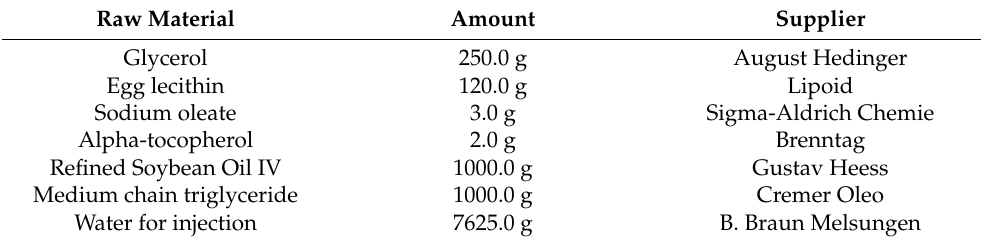
Table 1. Lipofundin MCT/LCT 20% recipe and raw material suppliers.